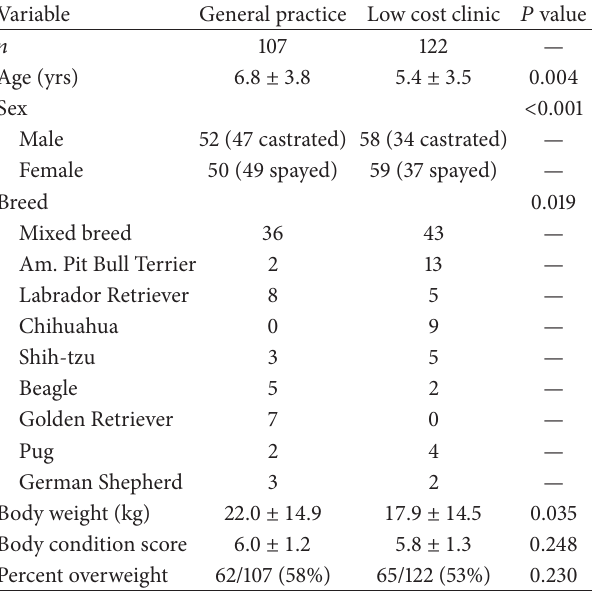
Table 2: Summary of dog demographic information from 229 dogs enrolled from two veterinary clinics (absolute number or mean ± SD). Only breeds reported more than 5 times were included in the table. Variable